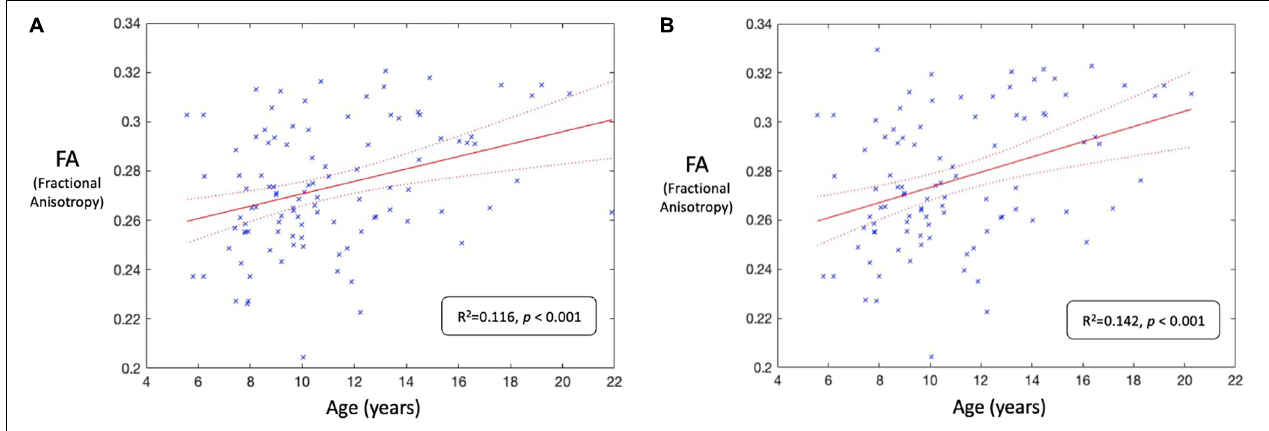
FIGURE 12 | (A) Correlation analysis between whole-brain fractional anisotropy (FA) and age (in years) for test A (i.e., all 100 HBN participants). The solid red line denotes the regression line, and the two curved red dashed lines denote the 95% confidence intervals. (B) Correlation analysis between whole-brain fractional anisotropy (FA) and age (in years) for test B (i.e., 100 HBN participants with some noisy (labeled by SE-CNN classifier) dMRI volumes removed). The solid red line denotes the regression line, and the two curved red dashed lines denote the 95% confidence intervals. The FA-age relationship improved after utilization of the labels generated by the model to stratify the